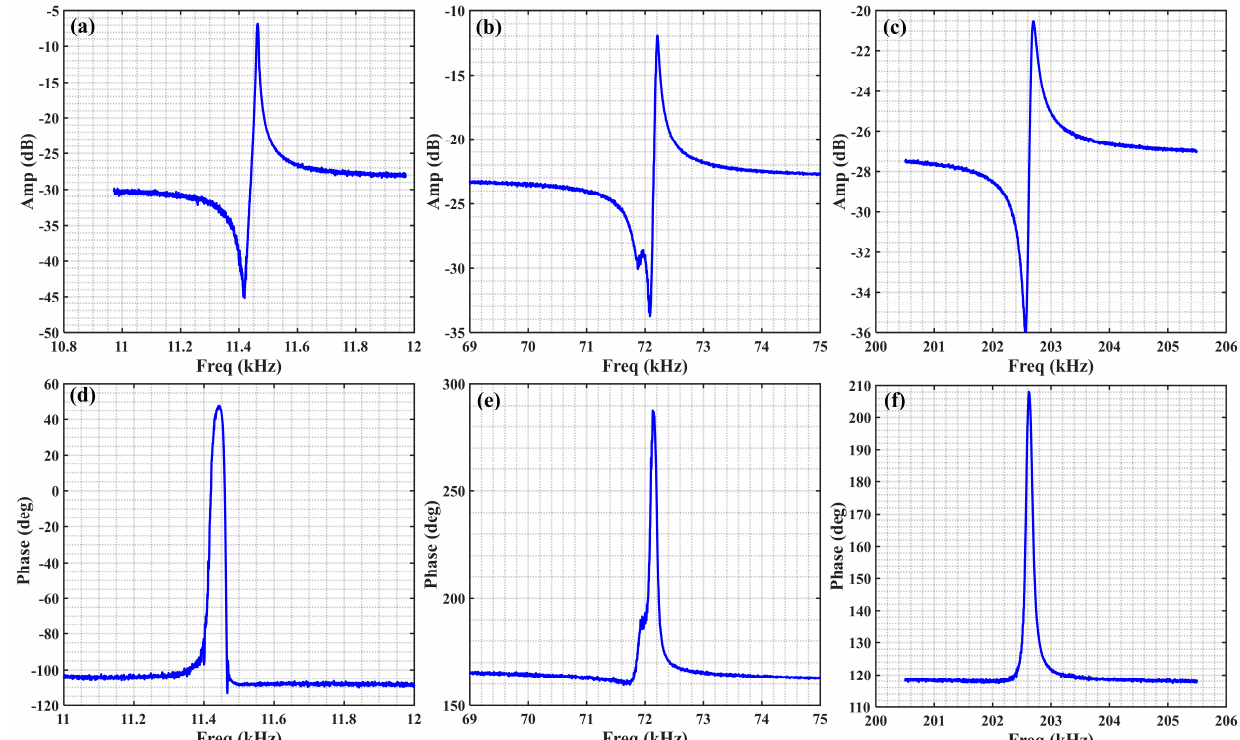
Figure 6. Measurements of S21 of the fabricated piezoelectric cantilever resonator, the 1st, 2nd, and 3rd-order resonance frequency are 11.463 kHz, 72.208 kHz, and 202.701 kHz, respectively. ( a–c ) The frequency–amplitude response curve of the 1st, 2nd, and 3rd-order resonance mode; ( d–f ) the frequency–phase response curve of the 1st, 2nd, and 3rd-order resonance mode.